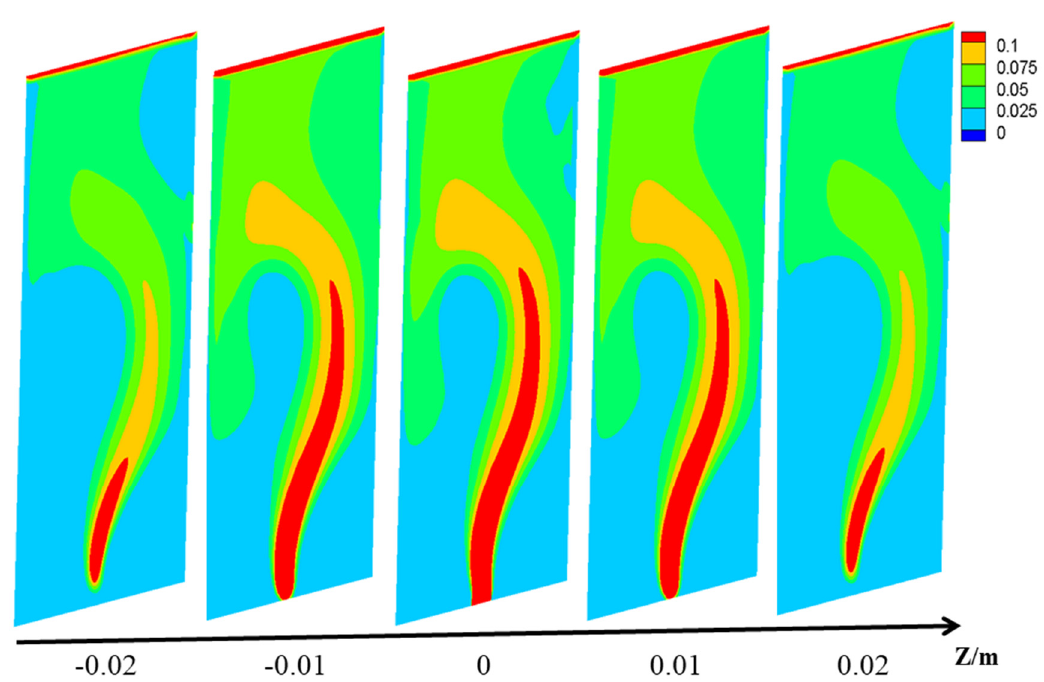
Figure 4. Contours of the gas hold-up over time (half-period, 15 s) for the five sections (Z = − 0.02, − 0.01, 0, 0.01 0.02).